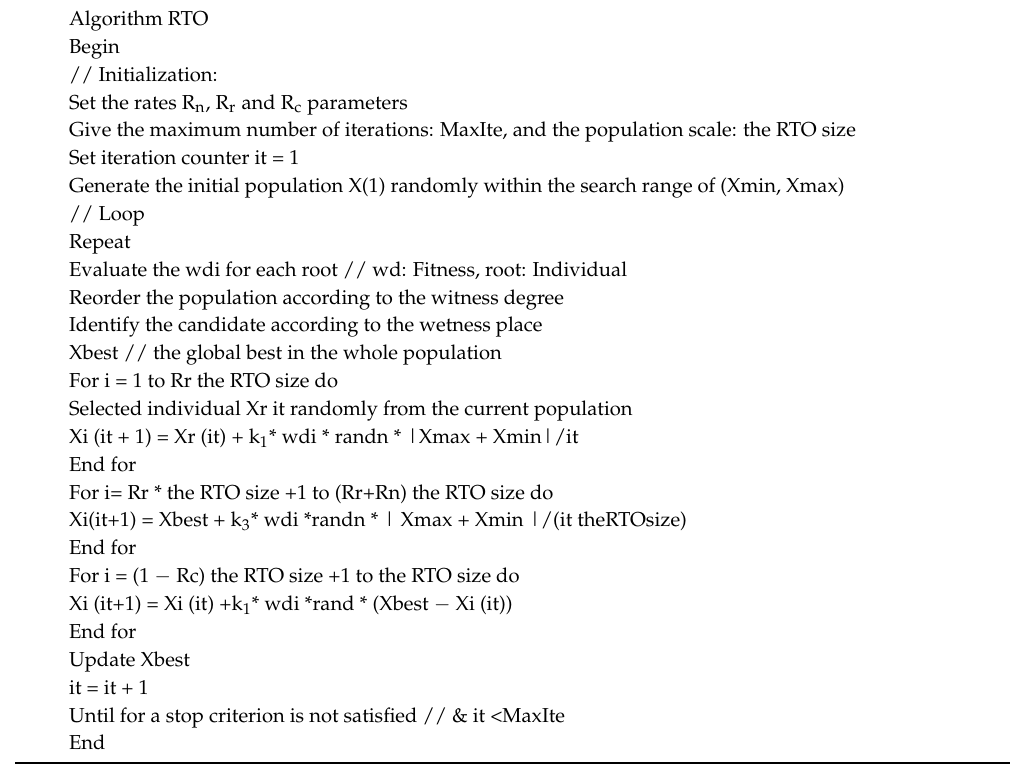
Algorithm 1. The structure of the new rooted tree algorithm [35]. Algorithm